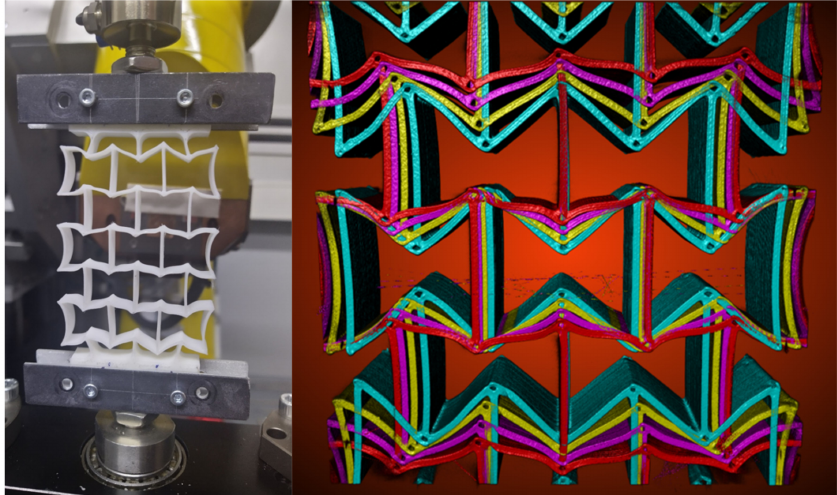
Figure 20. Deformed state of a 3 × 3 PBAT sample ( left ) and the overlapping view of the sample at loading state of 0 mm, 5 mm, 10 mm, and 15 mm presented with cyan, yellow, magenta, and red color, respectively ( right